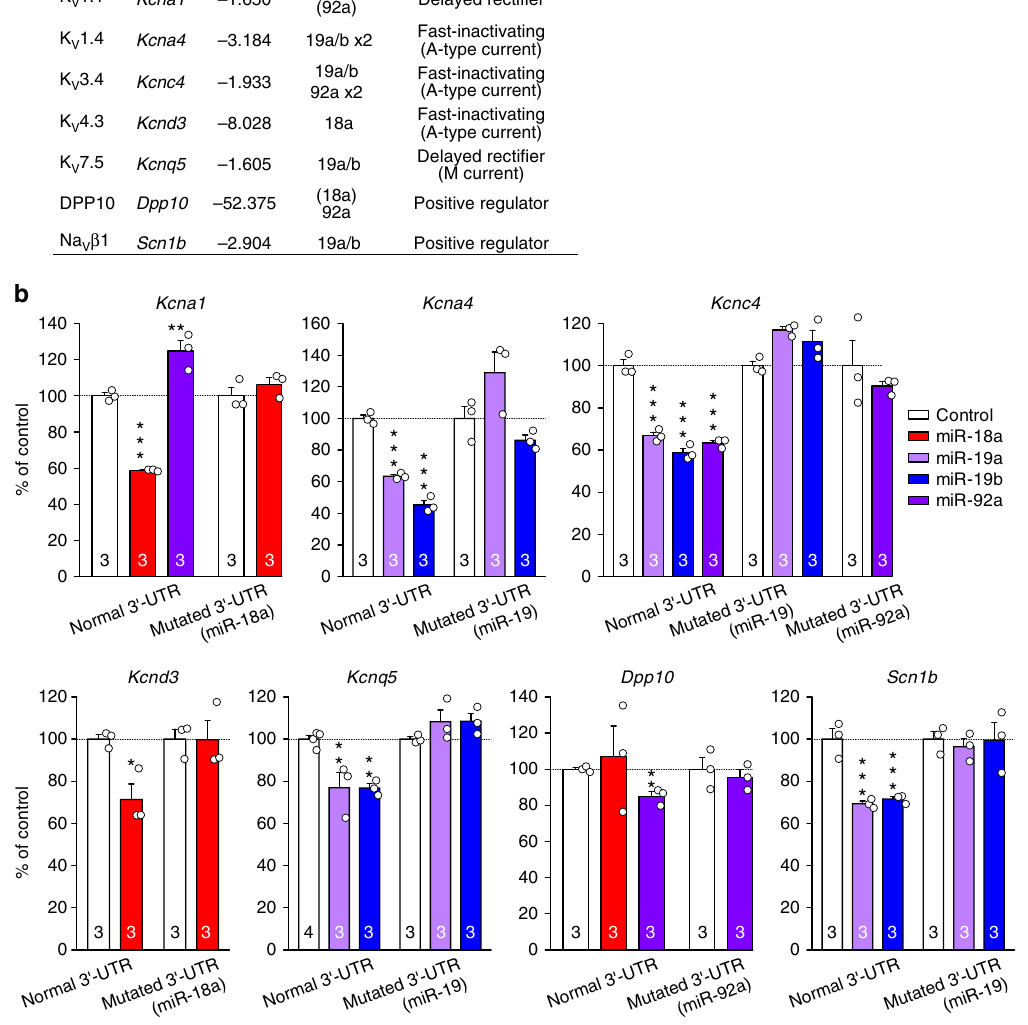
Figure 4 | miR-17-92 cluster members differentially target the 3 0 -UTR sequences of voltage-gated potassium channels and modulatory subunits. ( a ) List of voltage-gated potassium channel subunits predicted as miR-17-92 target genes; these subunits were reportedly downregulated in a previous microarray study of SNL 20 . Parenthesized targeting miRNAs represent predicted miRNAs not validated by a luciferase assay. ( b ) Activities of luciferase with voltage-gated potassium channel subunit 3 0 -UTRs or mutated 3 0 -UTRs in HEK293 cells co-transfected with control or miR-17-92 cluster member- expressing plasmid vector. Numbers of cell cultures are indicated at the base of each bar. Error bars are s.e.m. * P o 0.05, ** P o 0.01 and *** P o 0.001 ( Kcna1 , P o 0.001 for miR-18a and P ¼ 0.004 for miR-92a; Kcna4 , P o 0.001 for miR-19a and P o 0.001 for miR-19b; Kcnc4 , P o 0.001 for miR-19a, P o 0.001 for miR-19b and P o 0.001 for miR-92a; Kcnd3 , P ¼ 0.021 for miR-18a; Kcnq5 , P ¼ 0.008 for miR-19a and P ¼ 0.008 for miR-19b; Dpp10 , P ¼ 0.006 for miR-92a; Scn1b , P o 0.001 for miR-19a and P o 0.001 for miR-19b) compared with control plasmid, unpaired t -test or Dunnett’s